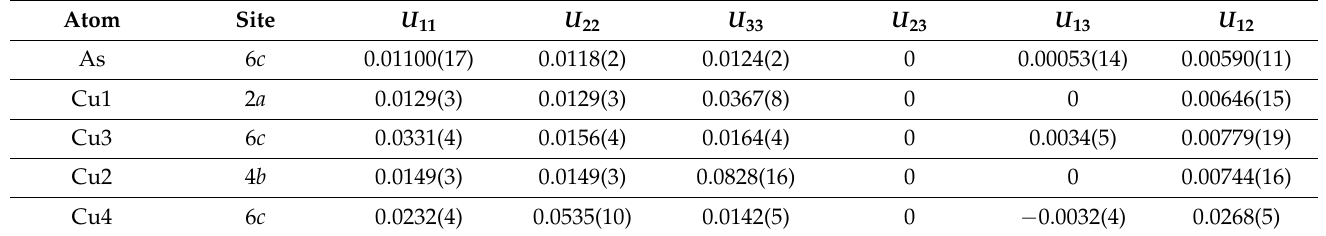
Table 3. Anisotropic displacement parameters for RT-Cu 2.881(7) As as obtained from single crystal investigation.